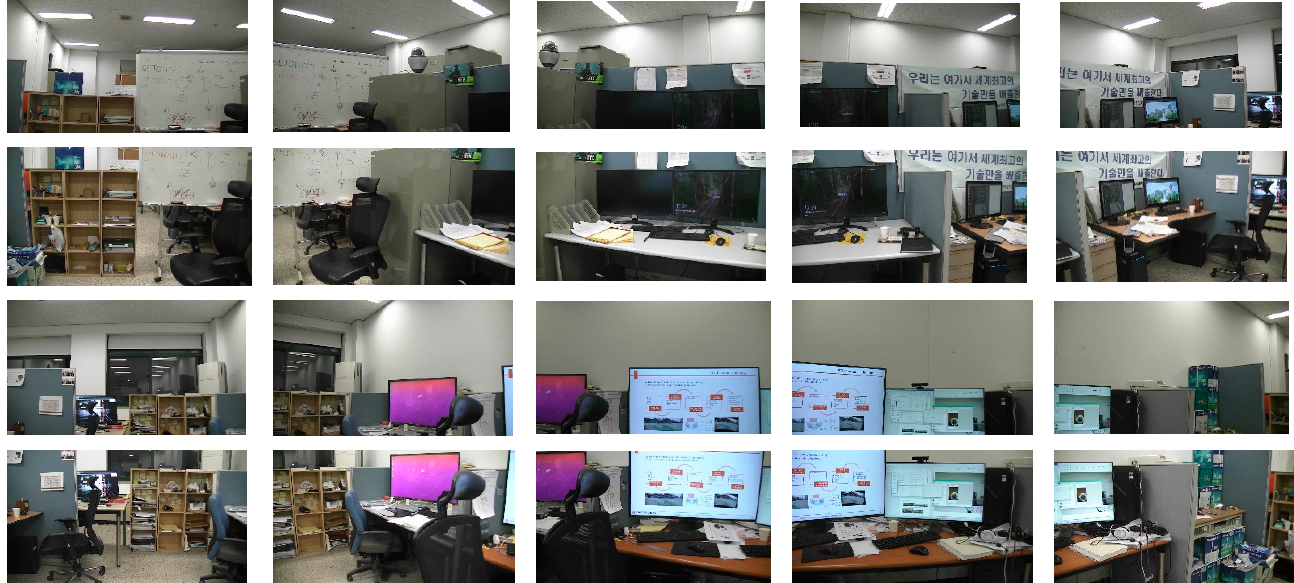
Figure 13. Panoramas from side: left (5800 × 1600 = 180° × 56°) and right (5800 × 1000 = 180° × 36°).